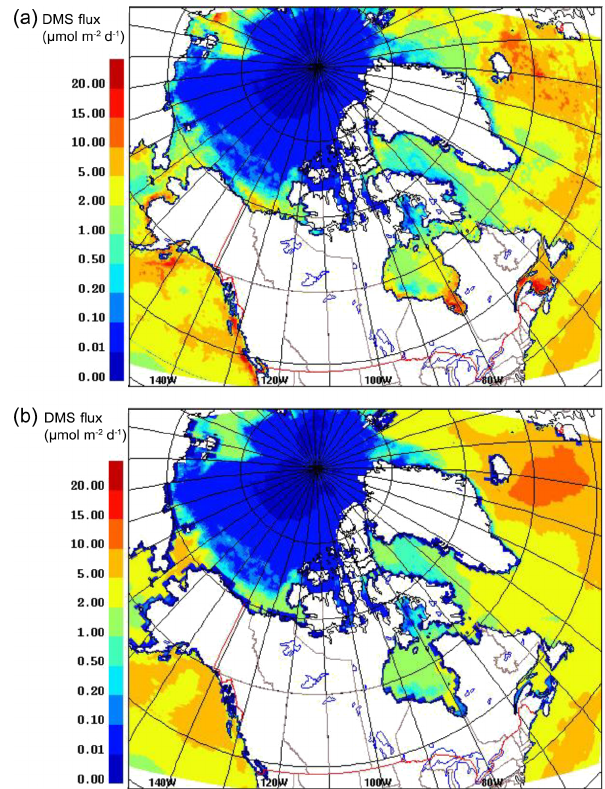
Figure 4. DMS sea–air average flux for July 2014 at 1.5m using SAT (a) and CLIM11 (b)